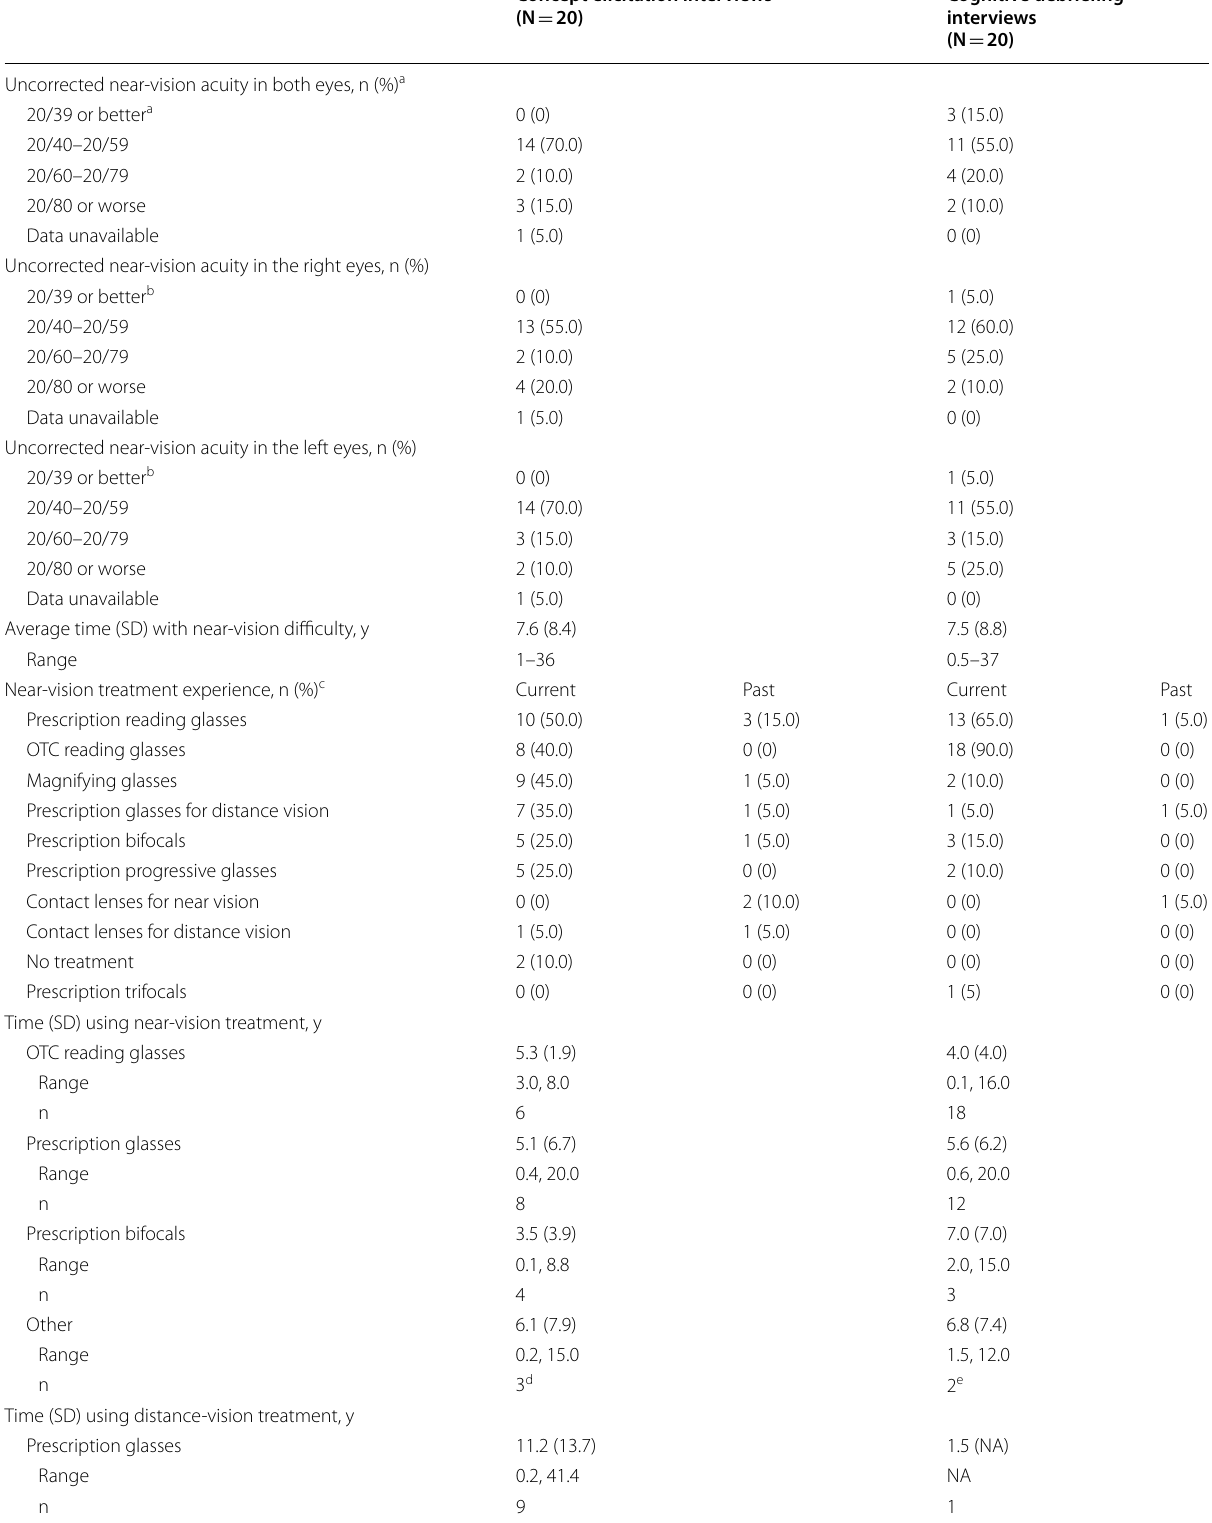
Concept elicitation interviews